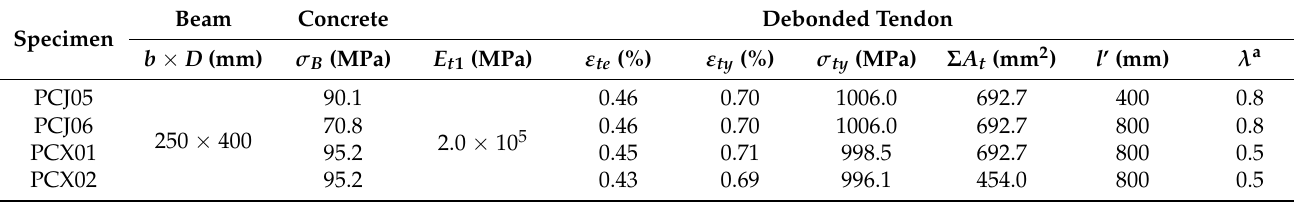
( b ) Figure 12. Crack maps: ( a ) PCJ05; ( b ) PCJ06. Figure 13 shows the beam shear force ( P b ) – beam deflection angle ( R b ) relationship obtained from the tests. In the figure, the ultimate flexural points, which are the maximum strength points, and the yielding points of the tendons are plotted. From the test results, for PCJ05 with shorter tendon, the maximum strength point and the tendon yielding point occurred at the smaller deflection angle. When the initial prestressing force became lower (PCX01 and PCX02), the maximum strength and yielding of the tendons occurred at the larger deflection angles. Moreover, if the tendon amount was reduced (PCX02), the max- imum strength decreased. It can be also seen in Figure 13 that the residual deformation gradually increased after the yielding of tendons, so setting the tendon length is very